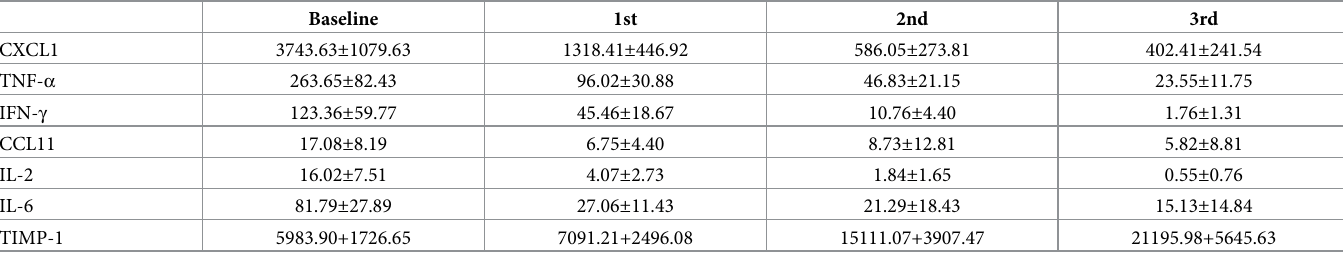
Table 2. Concentration of tear cytokines following each IPL treatment session.